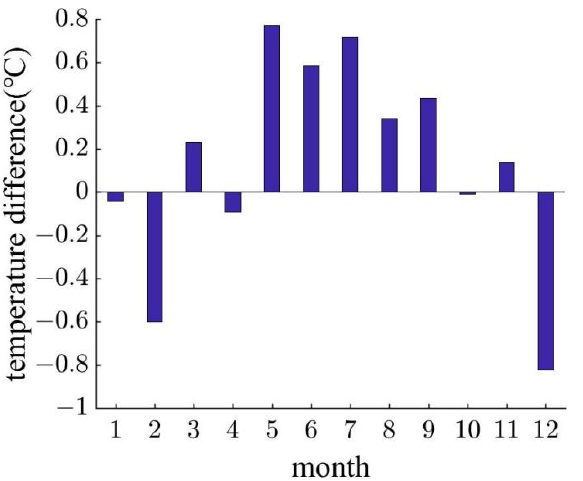
Figure 3. Temperature difference of monthly average maximum temperature between 2010–2019 and 1980–2009 in Jilin Province, China.